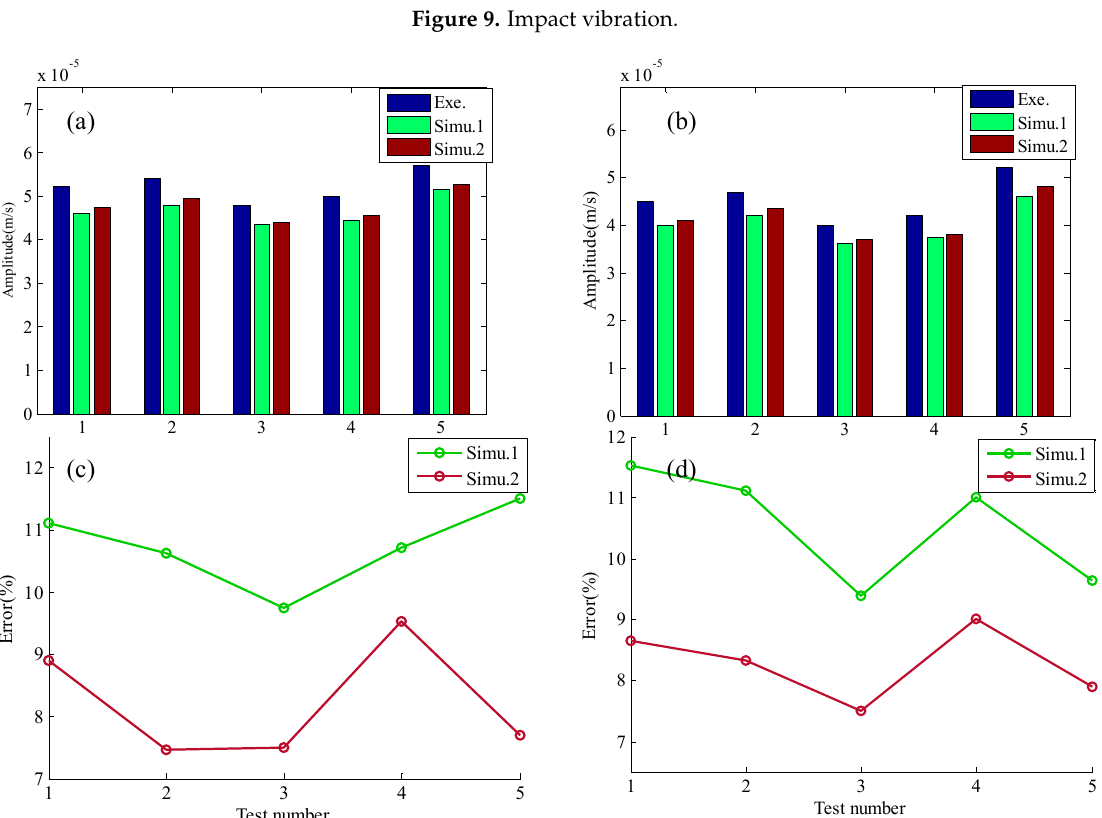
Figure 10. Simulation (Simu.1 and Simu.2) and experiment (Exe.) of cutting vibration: Simu.1-cutting vibration without impact vibration; Simu.2-cutting vibration with impact vibration; cutting vibration ( a ) x direction, ( b ) y direction; error ( c ) x direction, ( d ) y direction.